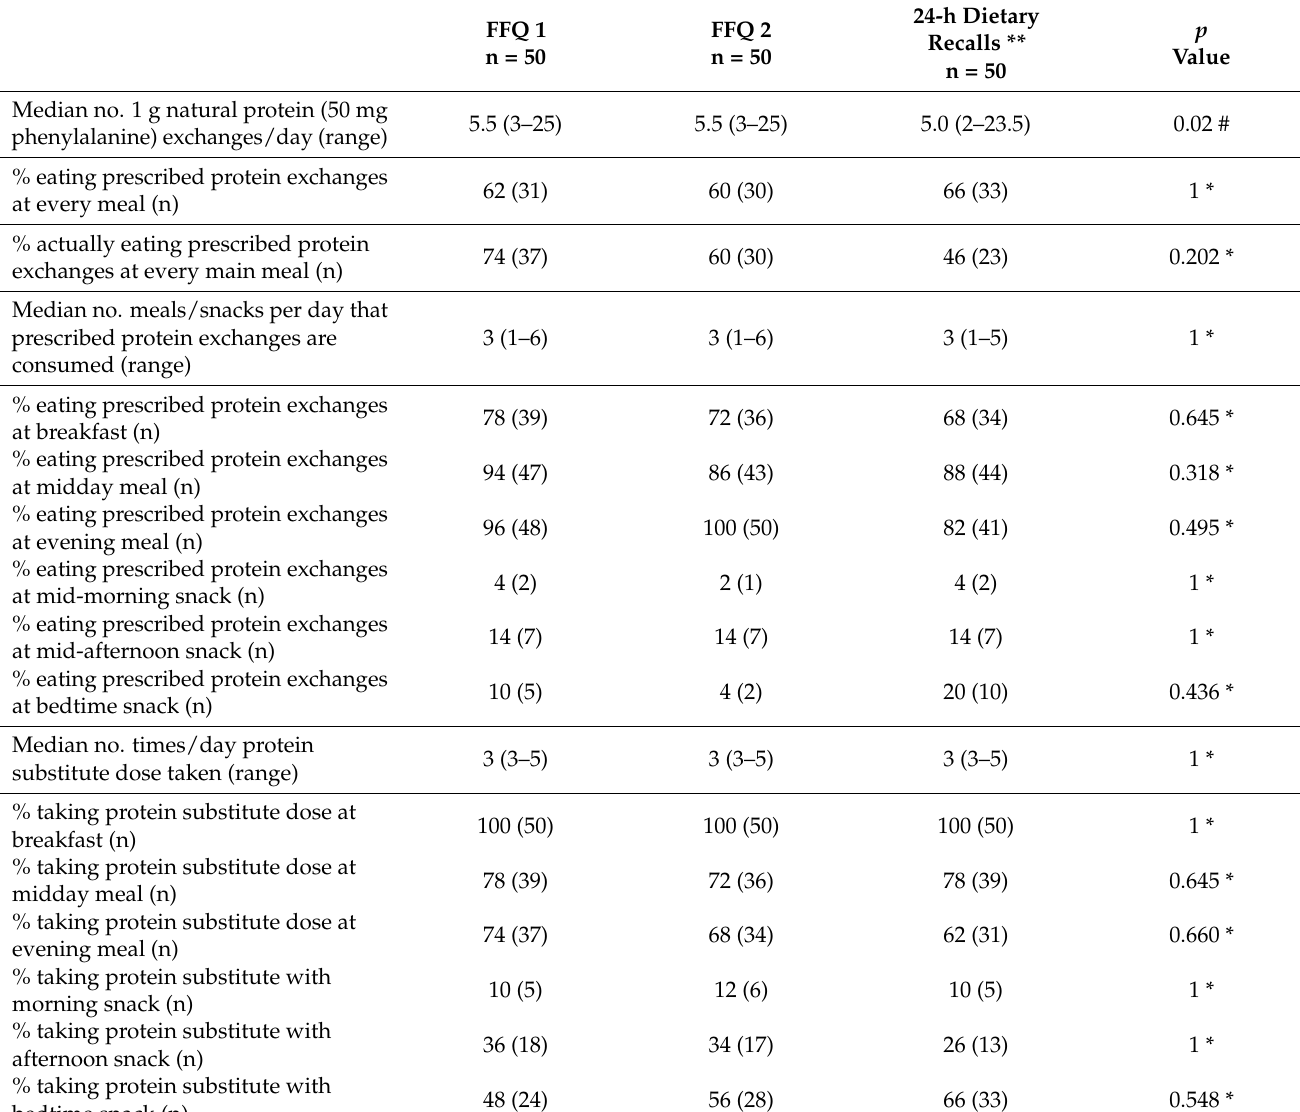
Table 2. Percentage of subjects consuming natural protein exchanges (1 g protein = 50 mg phenylala- nine) and protein substitute at meals and mid meals (PKU group